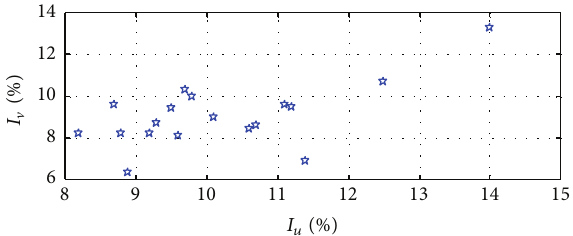
Figure 10: Relationship between 𝐼 𝑢 and 𝐼 V of Typhoon